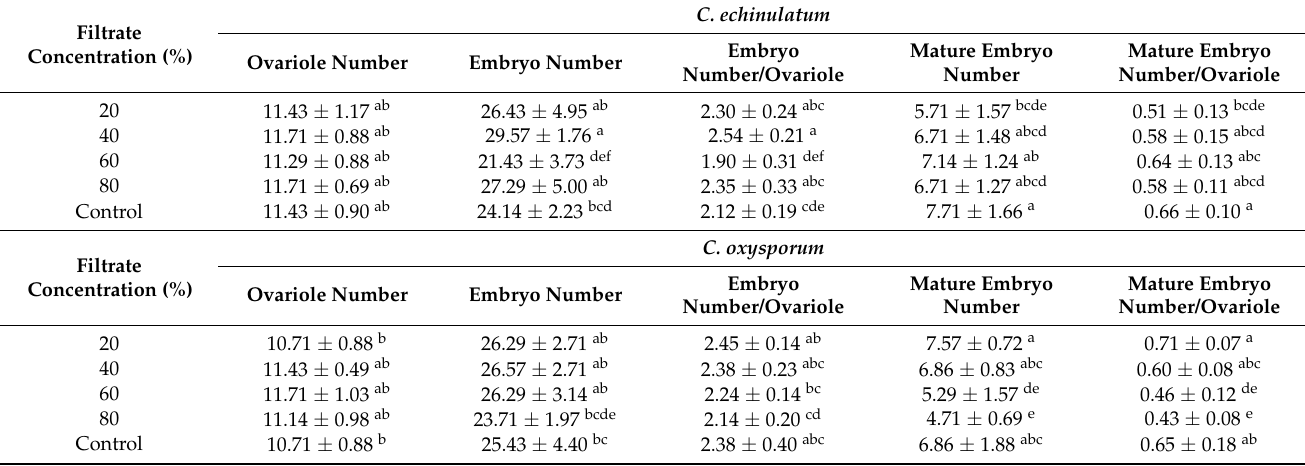
Table 3 demonstrated the effect of potato pre-treatment by invert emulsions on embry- onic traits of M. persicae apterous adults. The results showed that the embryo number per ovariole decreases in individuals sampled from plants treated with emulsions containing BEL21 filtrate (between 1.83 and 1.51 embryos/ovariole) compared to those sampled from untreated plants (2.37 embryos/ovariole) as well as the number of mature embryos per individual and per ovariole, which declined in dissected aphids sampled from plants treated with emulsions containing BEL21 filtrate (Table 3). Table 3. Effect of potato pre-treatment by invert emulsions on embryonic traits of M. persicae apterous